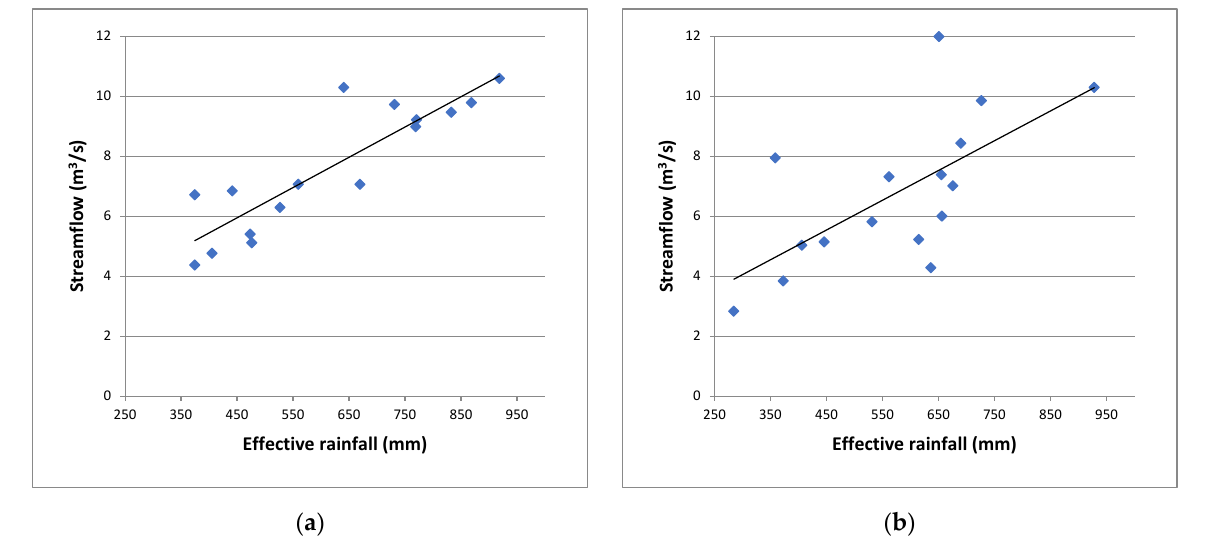
Figure 12. Scatter plots showing relationship between effective precipitation and streamflow, trend line in black colour: ( a ) 1964–1979 ( b ) 2005–2020.